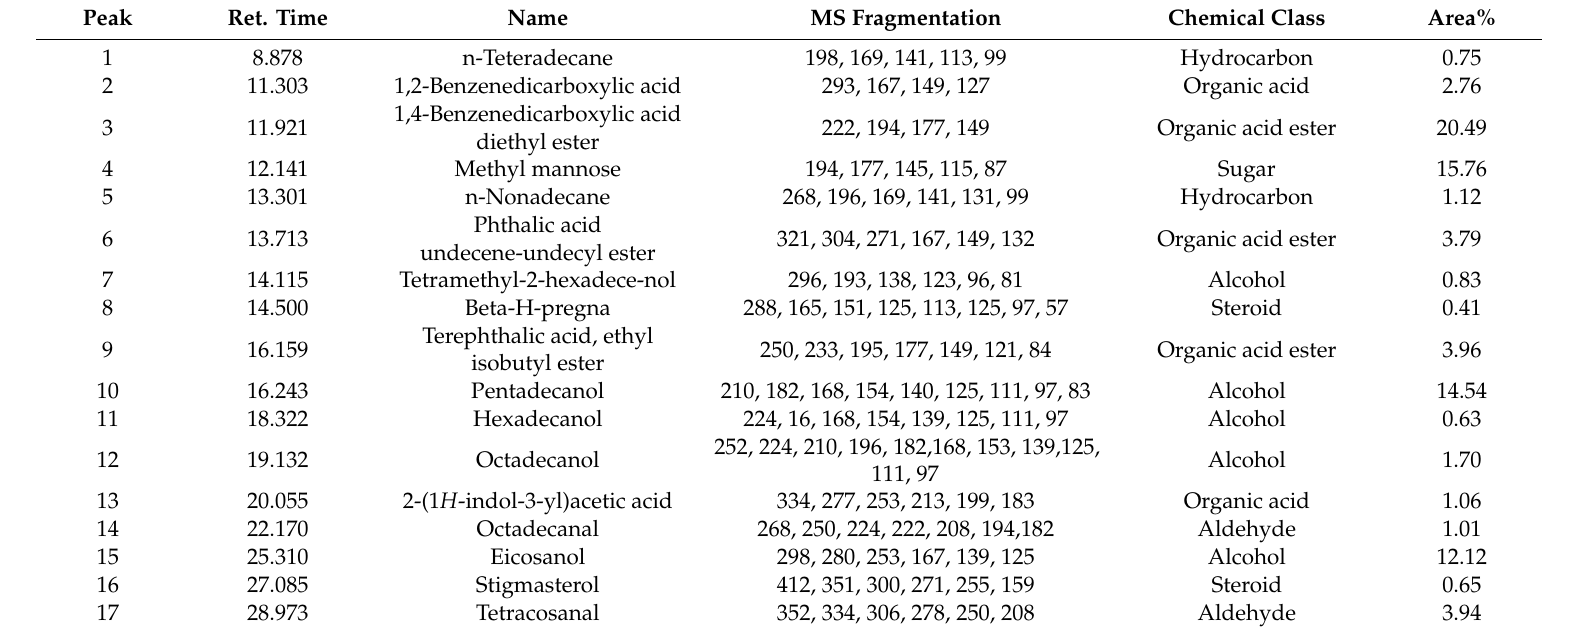
Table 3. Chemical components tentatively identified from ethanolic extracts of Calpurnia aurea using a gas chromatograph-mass spectrometer (GC-MS). Peak Ret.